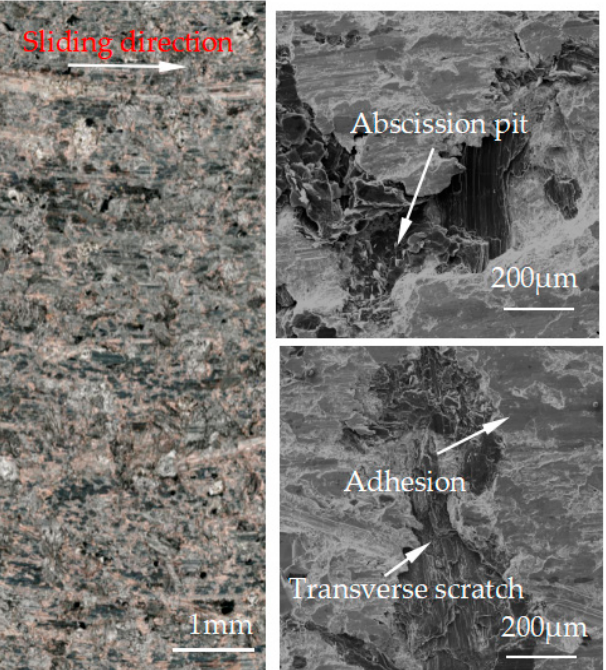
Figure 9. Surface morphology of the pad material after intermittent braking at an ambient temper- ature of − 10 °C.